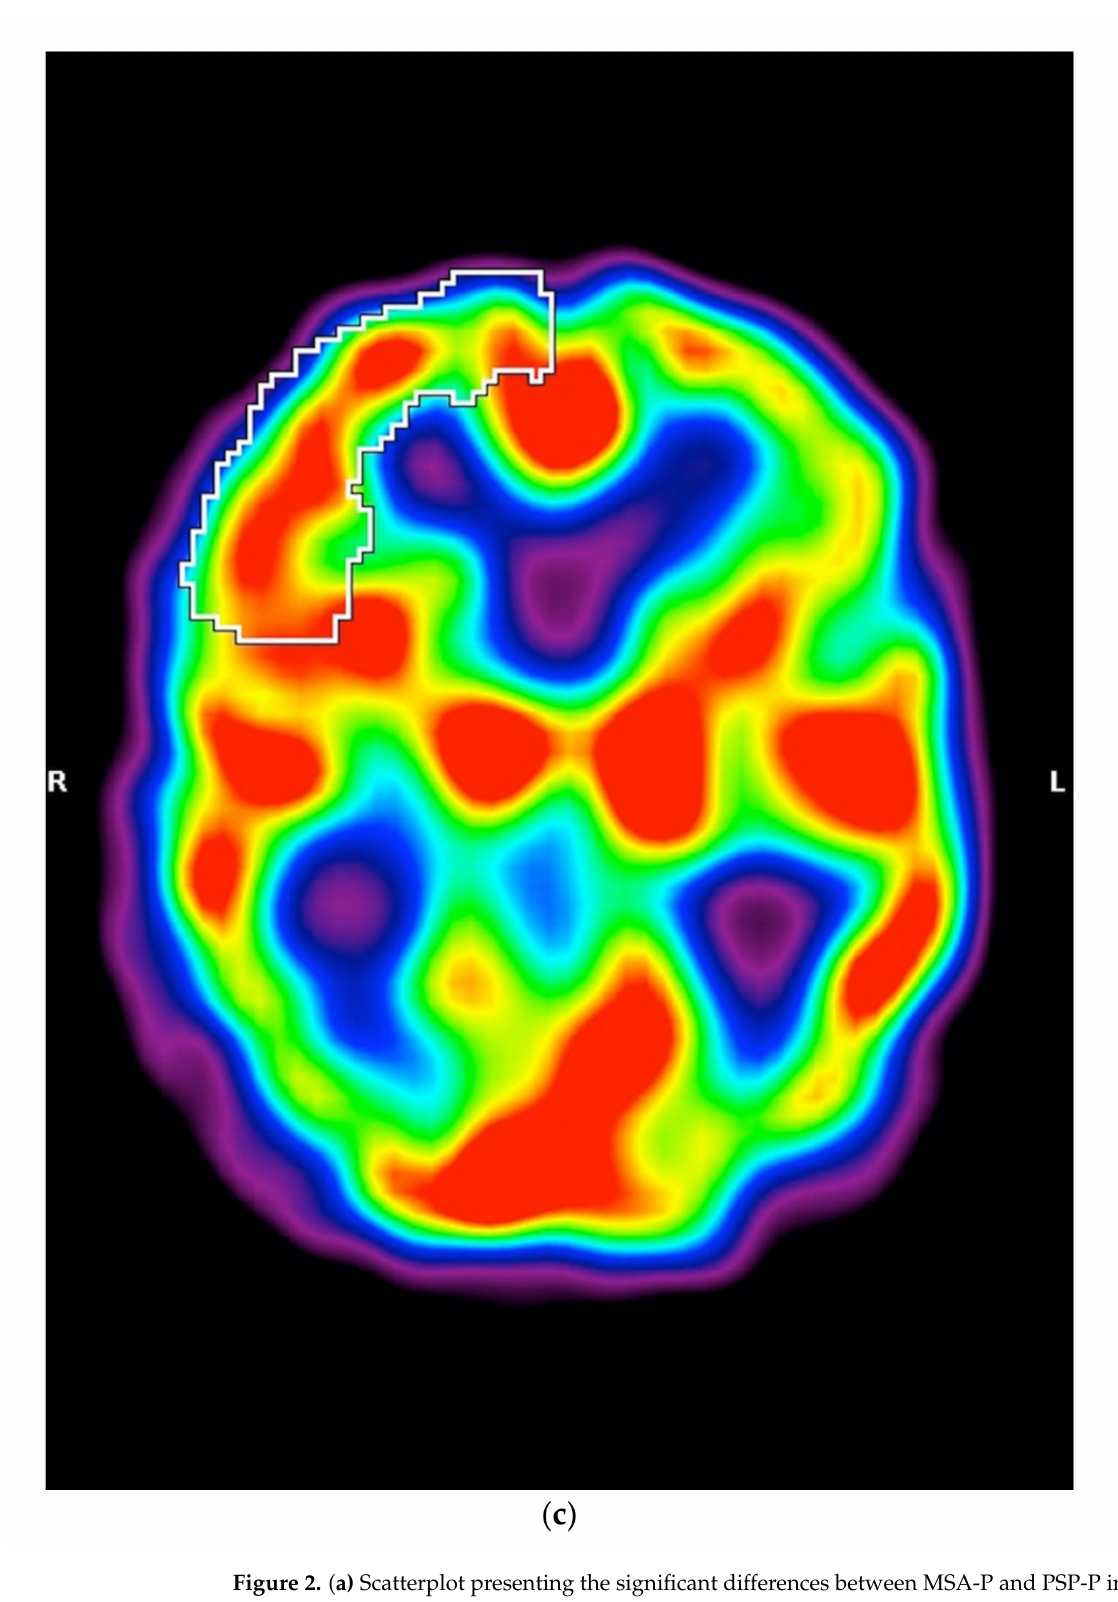
Figure 2. ( a) Scatterplot presenting the significant differences between MSA-P and PSP-P in the right frontal lobe, ( b ) Axial 99mTc-HMPAO SPECT of a patient with PSP-P (frontal lobe hypoperfusion), ( c ) Axial 99mTc-HMPAO SPECT of a patient with MSA-P (without frontal lobe